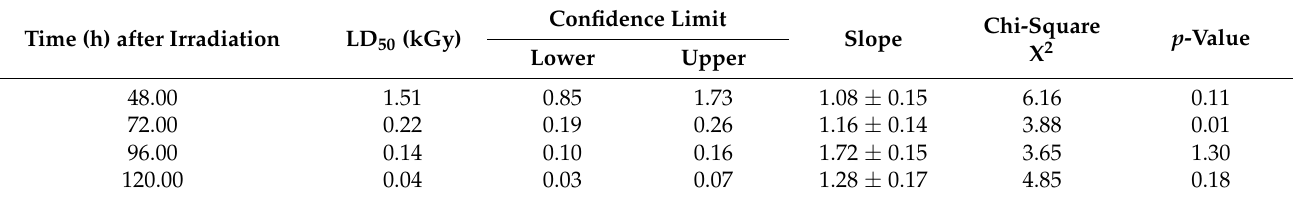
Table 3. Lethal effect of gamma radiation on S. oryzae at different times (h).